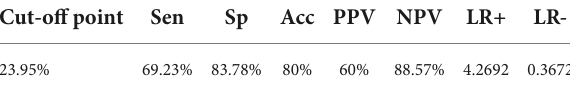
TABLE 5 Reliability of the diaphragm thickening fraction (DTF) in emergency